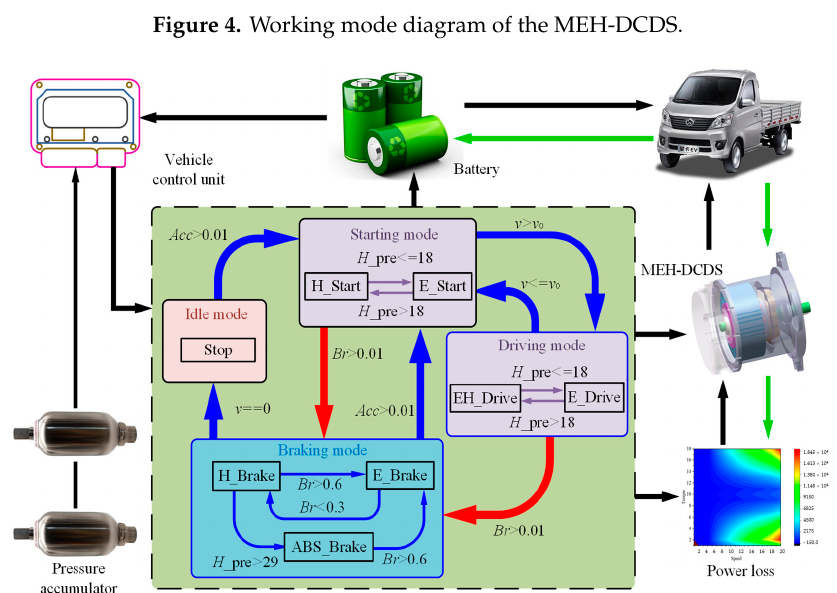
Figure 5. Energy management strategies of the